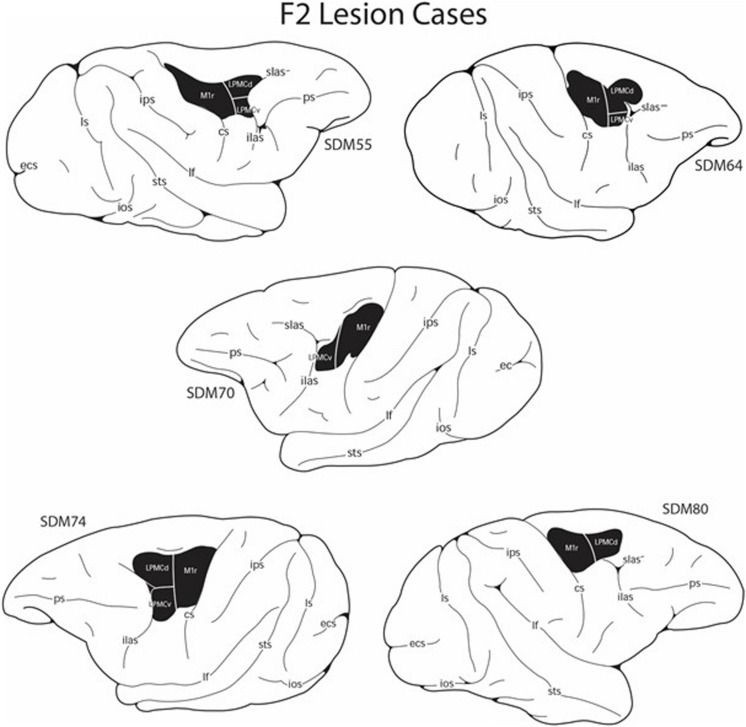
Line drawings of the lateral surface of the cerebral cortex showing the M1 + LPMC lesion site locations (blackened area) in the five F2 lesion cases. Detailed descriptions of the histological and cytoarchitectonic characteristics of each lesion are provided in previous reports along with microstimulation maps of the cortical surface that were used to guide the placement of each lesion (Darling et al., 2009; McNeal et al., 2010). cs, central sulcus; ecs, ectocalcarine sulcus; ilas, inferior limb of the arcuate sulcus; ios, inferior occipital sulcus; ips, intraparietal sulcus; lf, lateral fissure; ls, lunate sulcus; ots, occipito-temporal sulcus; ps, principal sulcus; slas, superior limb of the arcuate sulcus; sts, superior temporal sulcus.